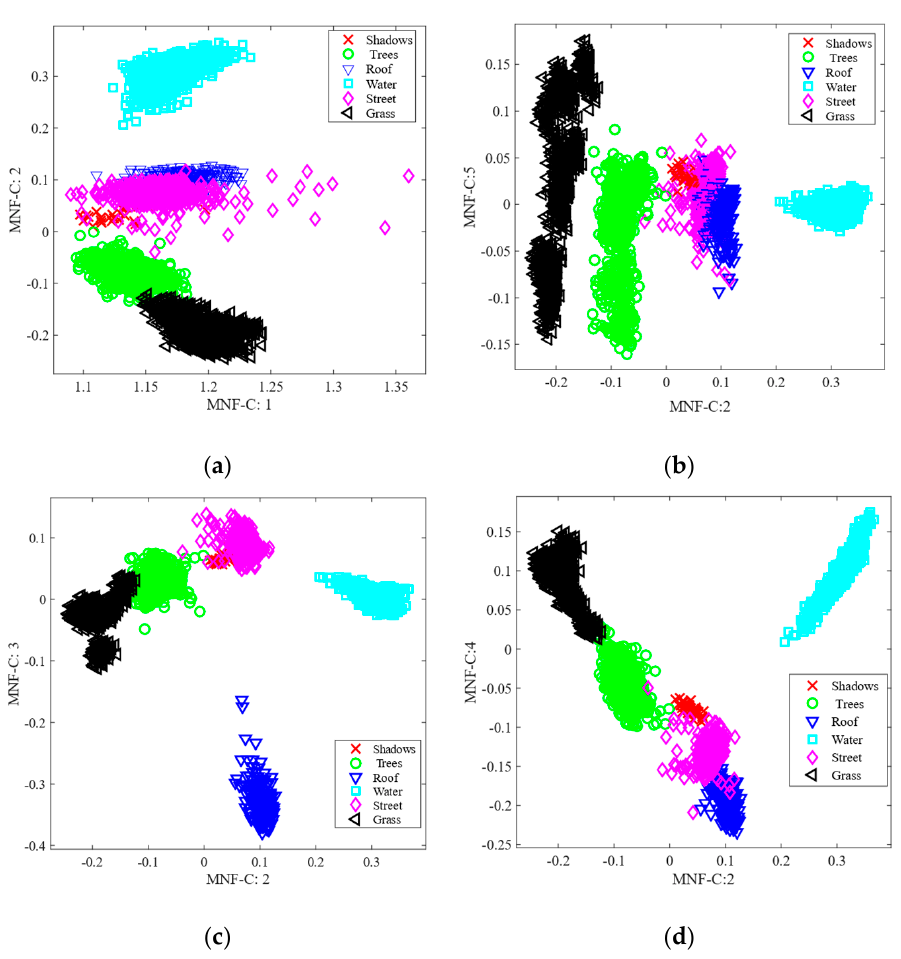
Figure 10. Feature space on the HYDICE WDM dataset: ( a ) MNF; ( b ) MNF-MI; ( c ) MNF-CCRE; and ( d ) MNF-nCCRE mRMR .